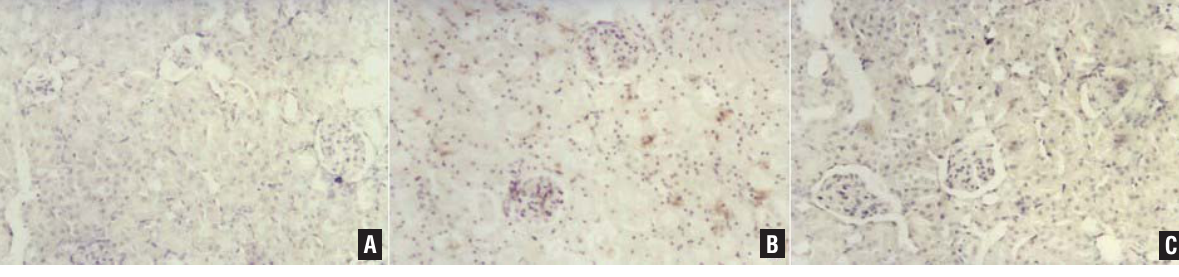
Figure 2 - Histology fi gures of ICAM-1 expression in the three groups. A) Control; B) IR; C) IP.